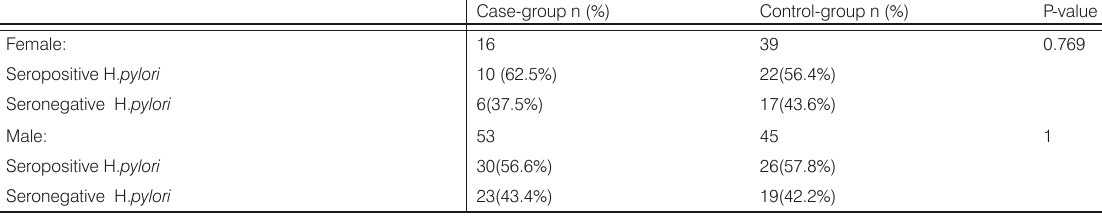
Table 2. Distribution of H. pylori infection seropositivity in the groups in terms of sex.